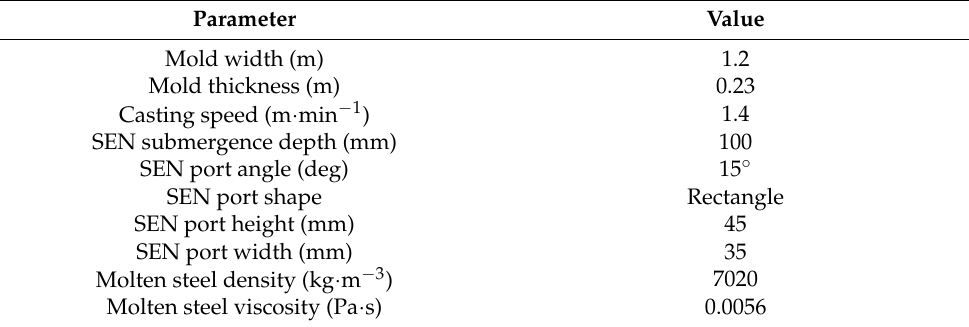
Table 1. Simulation conditions considered in the model. Parameter